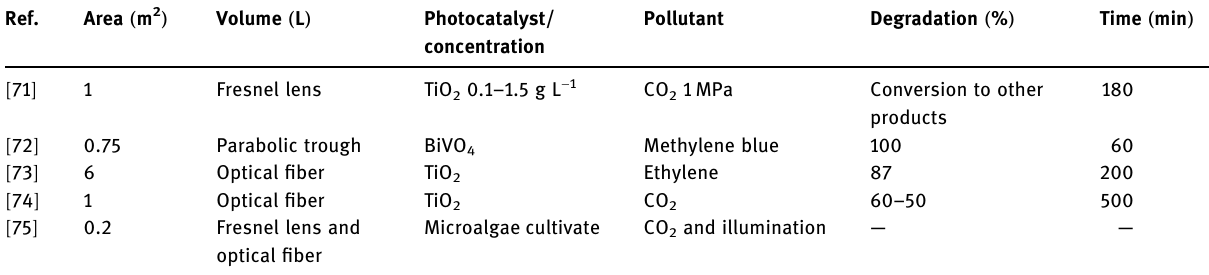
Table 3: Photocatalysis systems using Fresnel lens, parabolic trough, or optical fi ber for lighting Ref.